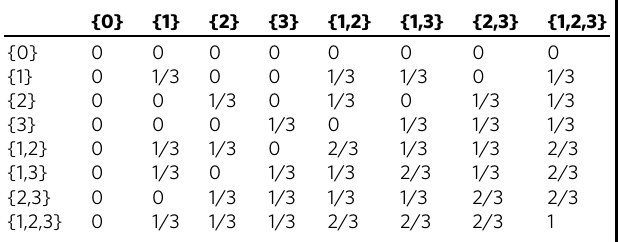
Table 2 The Shapley value of row coalition I to